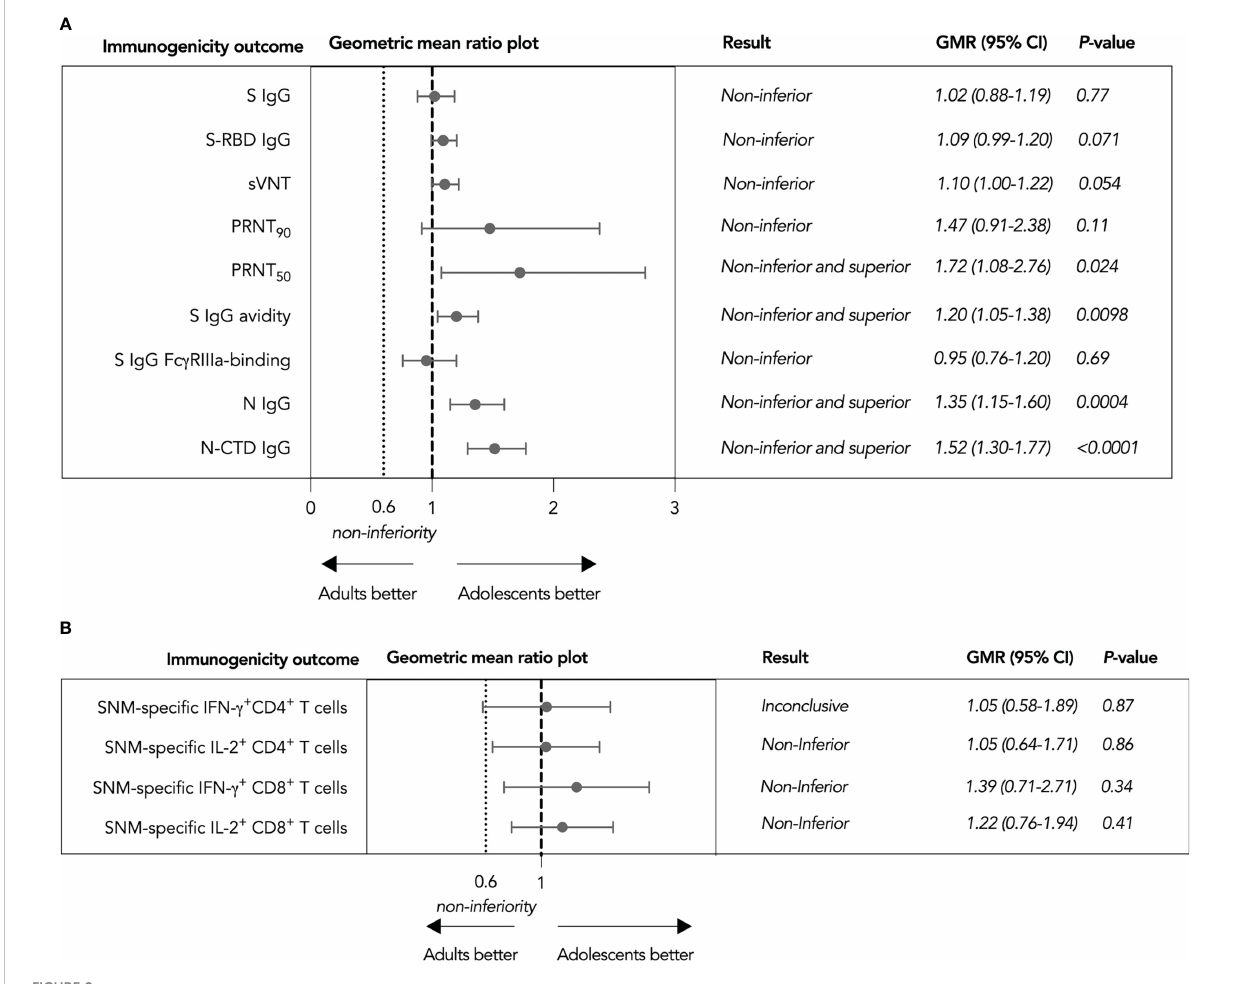
FIGURE 2 Non-inferiority hypothesis testing of humoral and cellular immunogenicity outcomes against wild-type SARS-CoV-2 after the third dose of CoronaVac in evaluable analysis population. (A) Non-inferiority testing of SARS-CoV-2 Spike (S) IgG, S-receptor binding domain (S-RBD) IgG, surrogate virus neutralization test (sVNT), plaque reduction neutralization test (PRNT), S IgG avidity, S IgG Fc g receptor IIIa (Fc g RIIIa)-binding, Nucleocapsid (N) IgG, and N-C-terminal domain (N-CTD) IgG (B Non-inferiority testing of total S, N and Membrane (M) protein-speci fi c interferon- g (IFN- g )+ and interleukin-2 (IL-2)+ CD4+ and CD8+ T cells Geometric mean ratios (GMR) and two-tailed 95% con fi dence intervals (CI) were